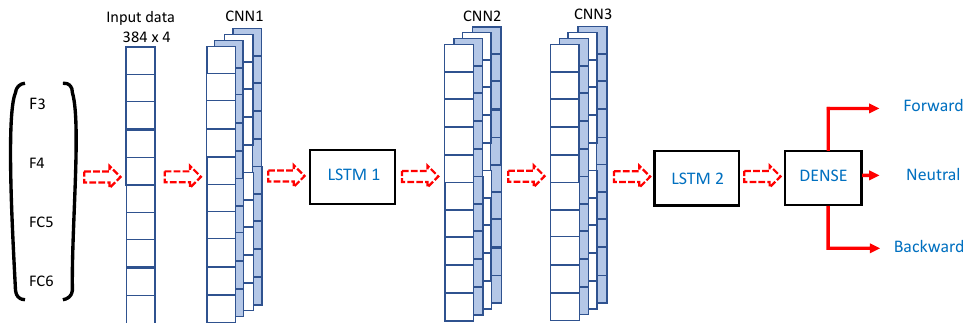
Figure 8. The proposed CNN-LSTM network architecture. A convolutional layer extracts features from preprocessed data, followed by an LSTM layer and two CNN layers, directly connected to a second LSTM layer and a dense layer to classify MI-EEG signals into the robot